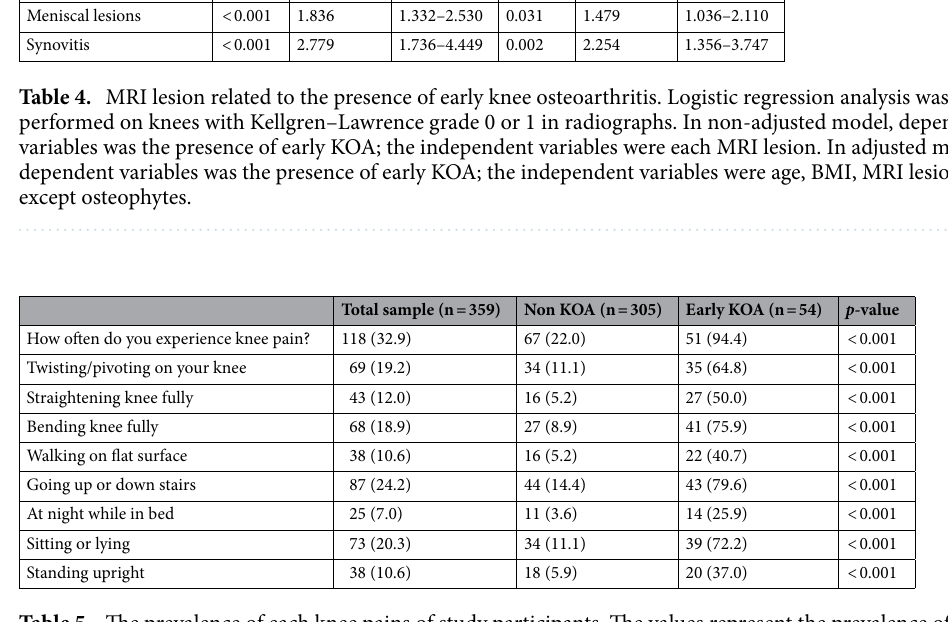
Table 5. The prevalence of each knee pains of study participants. The values represent the prevalence of each knee pains of all participants, participants with early KOA, and those without KOA. Data are based on the number of participants (percentage of the whole population) for each knee pains. Differences among the two groups were compared by chi-square test. A p -value indicates the significance of difference between participants with and without early